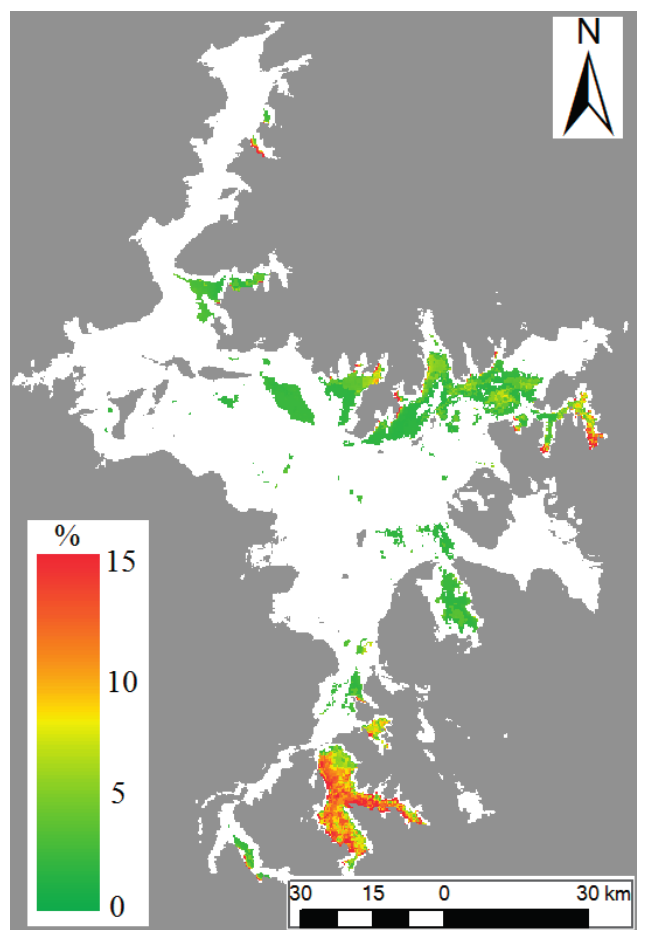
Figure 14. Occurrence frequency of high Chl-a (>10 mg·m − 3 ) between July and